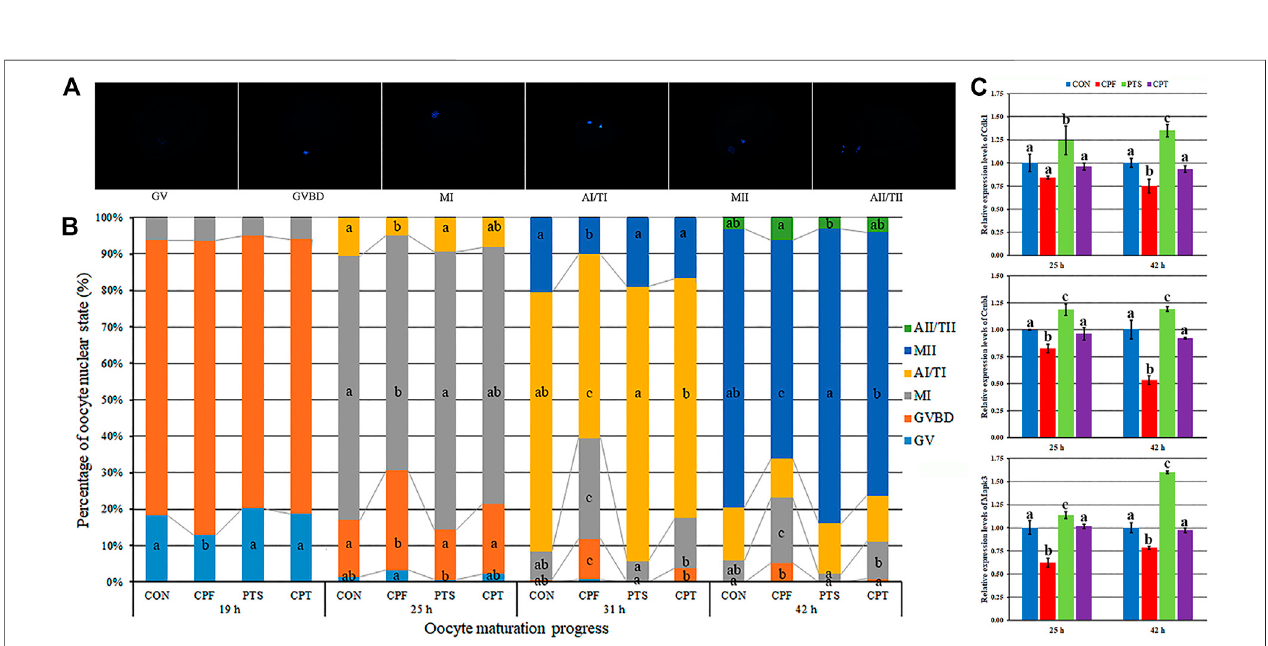
FIGURE 2 | Effect of CPF and PTS on oocyte nuclear maturation progression. (A) , nuclear morphology ( × 400). (B) , percentage of nuclear state. (C) , relative expression of MPF and MAPK related genes. a-c Values for a given state or group with different superscripts differ signi fi cantly ( p < 0.05).